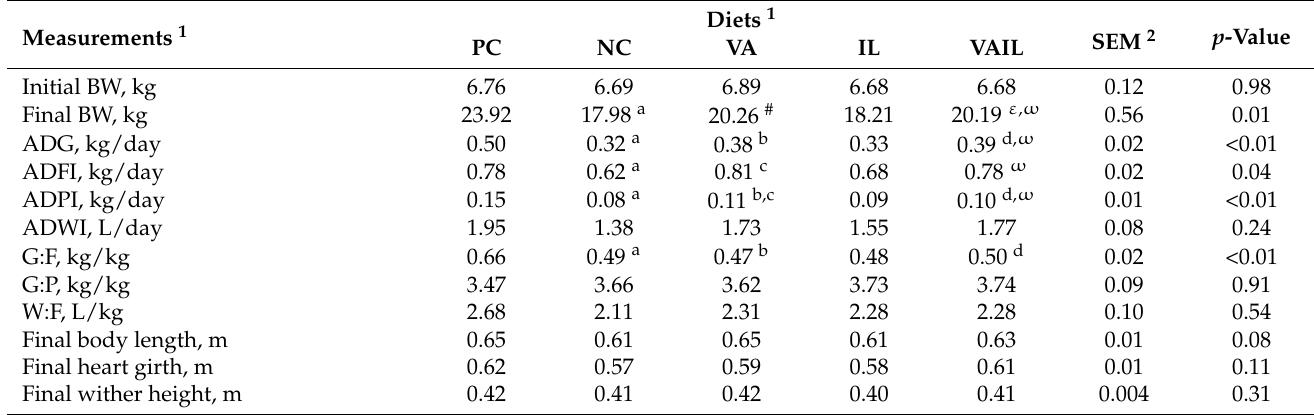
Table 1. Growth performance of nursery pigs fed with very low-protein diets supplemented with isoleucine at NRC and valine above NRC levels, or a combination of the two.